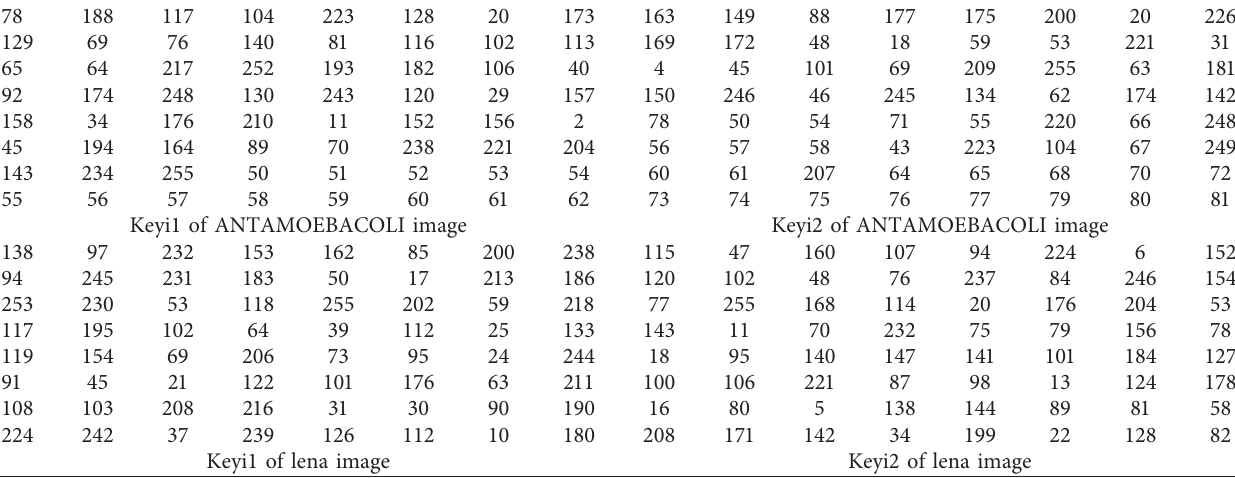
Figure 1: The block diagram of our proposed algorithm. Table 1: Internal keys of two images: ANTAMOEBACOLI and